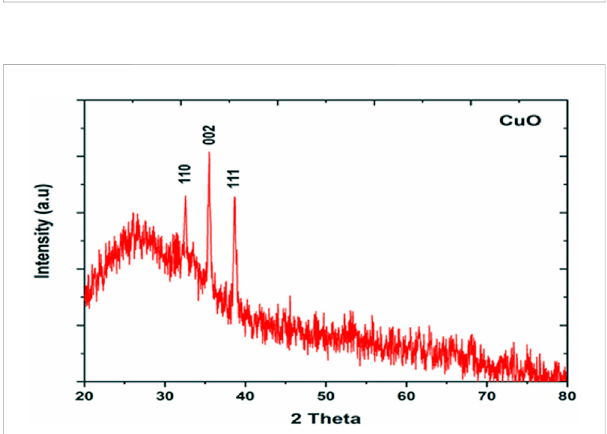
FIGURE 5 TEM analysis of biogenic CuO nanoparticles.